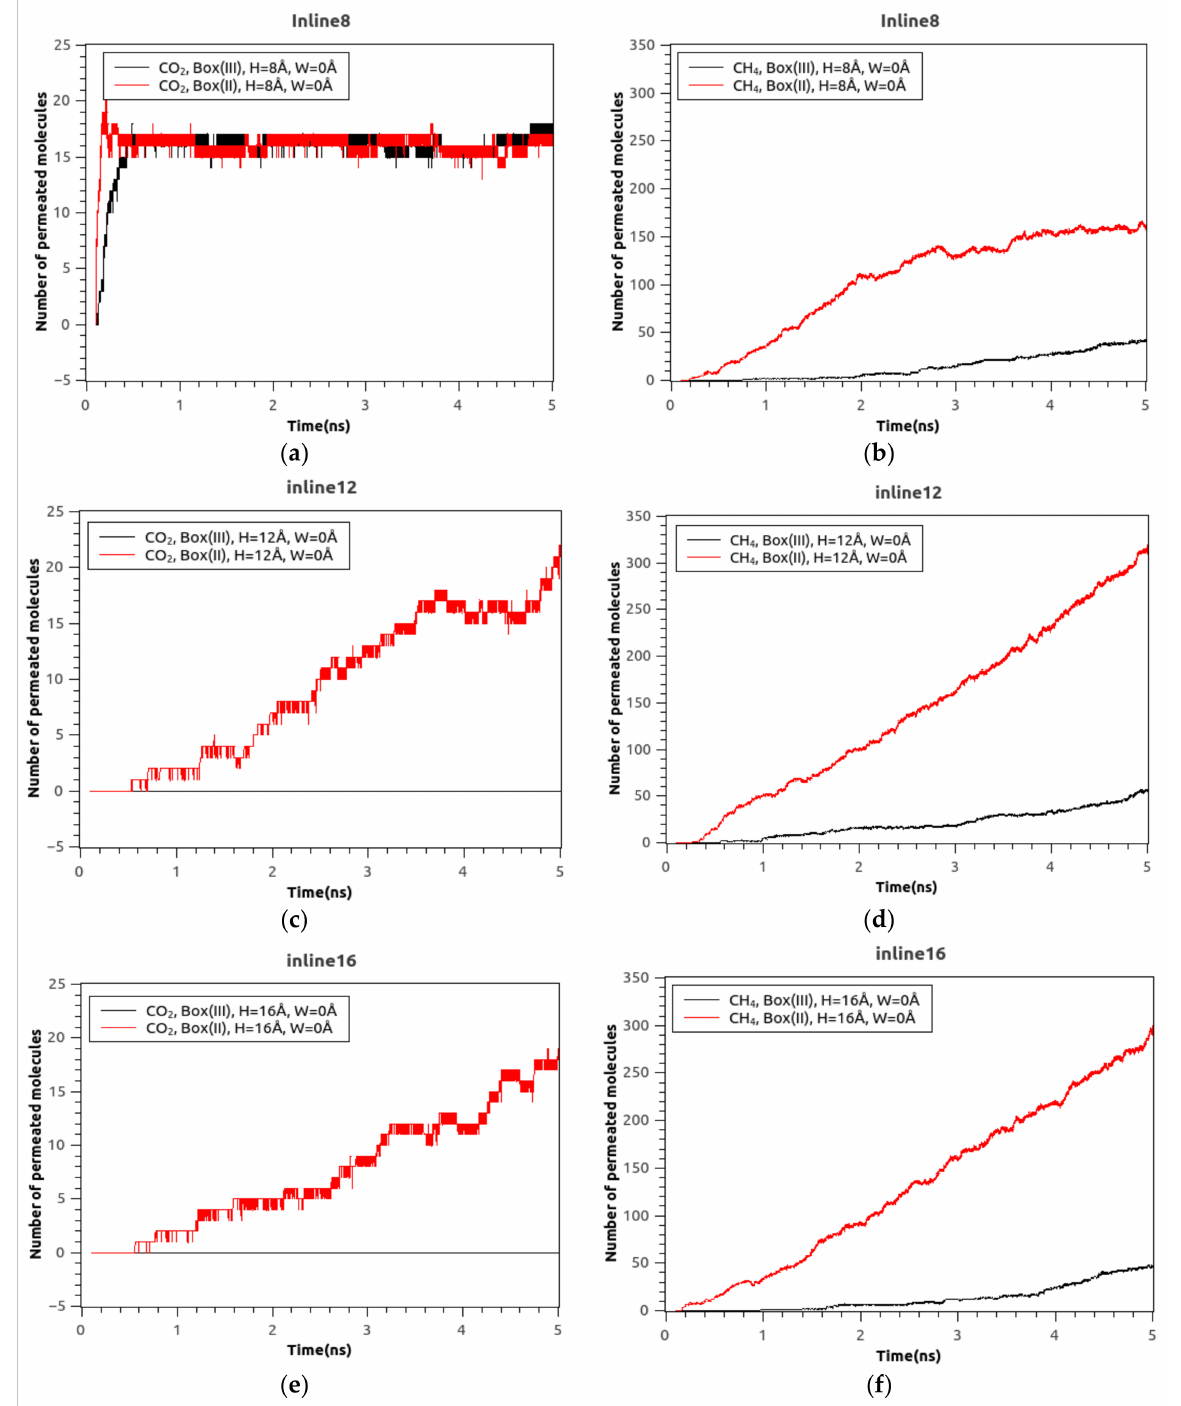
Figure 4. Time-varying number of molecules in the chamber(II) and chamber(III) permeated across the two-stage bilayer NPG for the inline configuration (W = 0 Å) of ( a ) CO 2 , H = 8 Å ( b ) CH 4 , H = 8 Å ( c ) CO 2 , H = 12 Å ( d ) CH 4 , H = 12 Å ( e ) CO 2 , H = 16 Å ( f ) CH 4 , H = 16